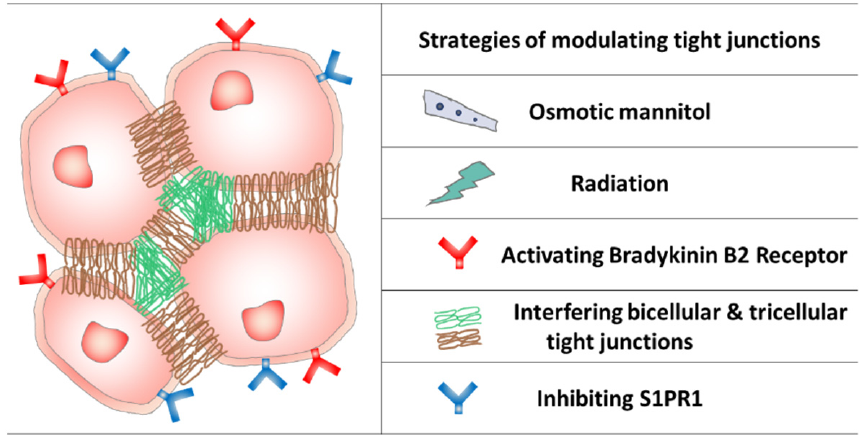
Figure 2. The BBB tight junctions and typical modulation strategies.